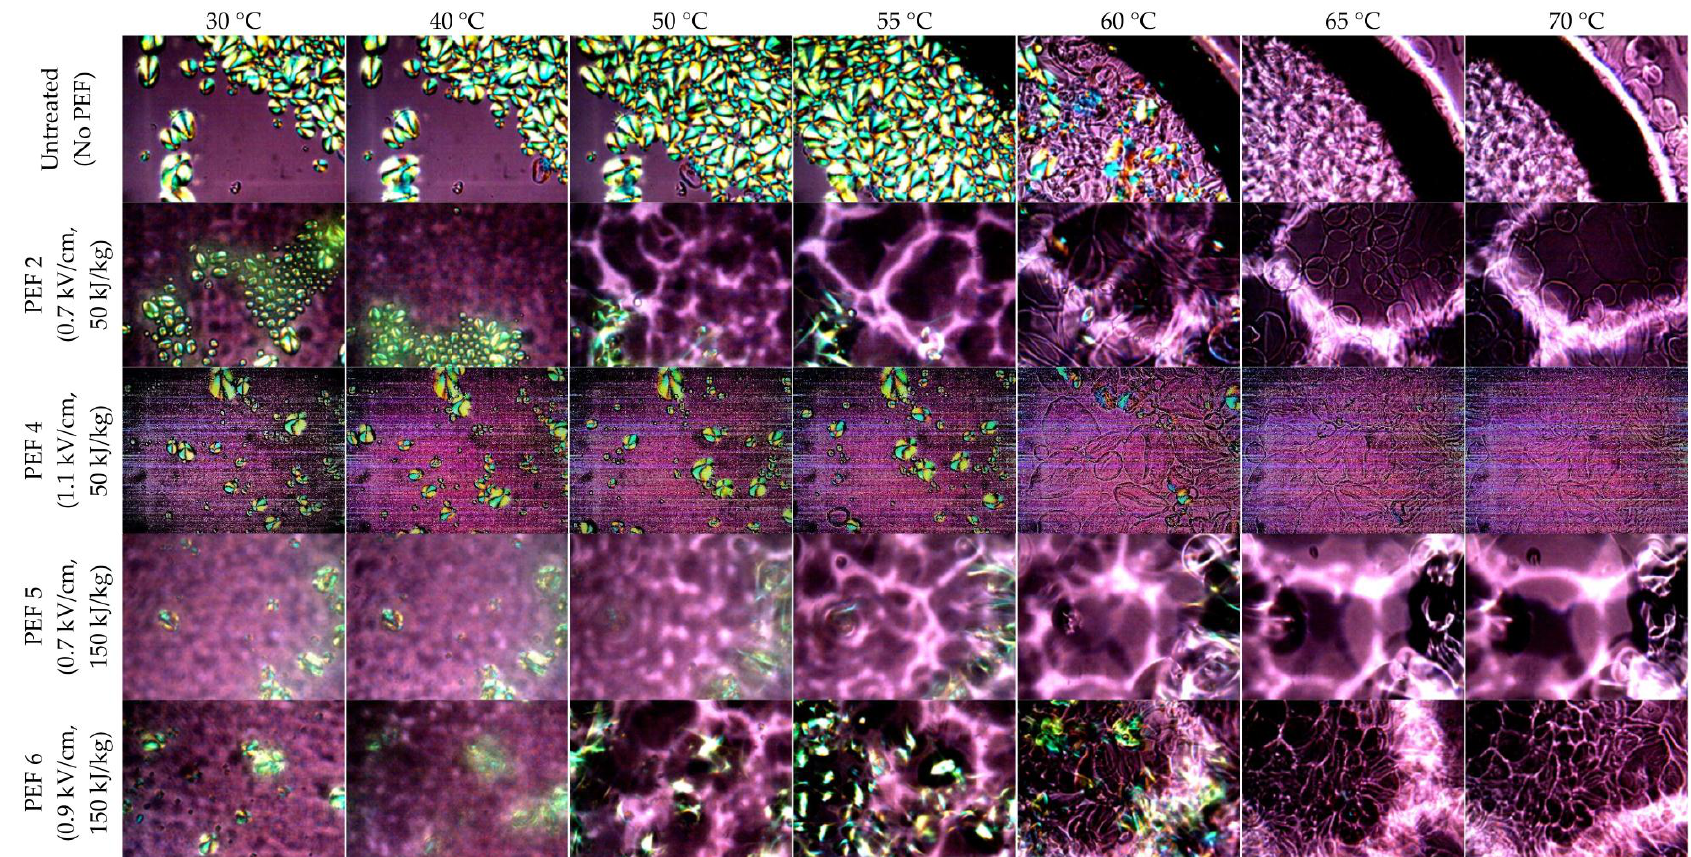
Figure 3. Selected photomicrographs, at a magnification of 200×, of isolated starches from untreated and PEF-treated potatoes, dispersed in water and heated from 30 to 70 °C at a rate of 5 °C/min.